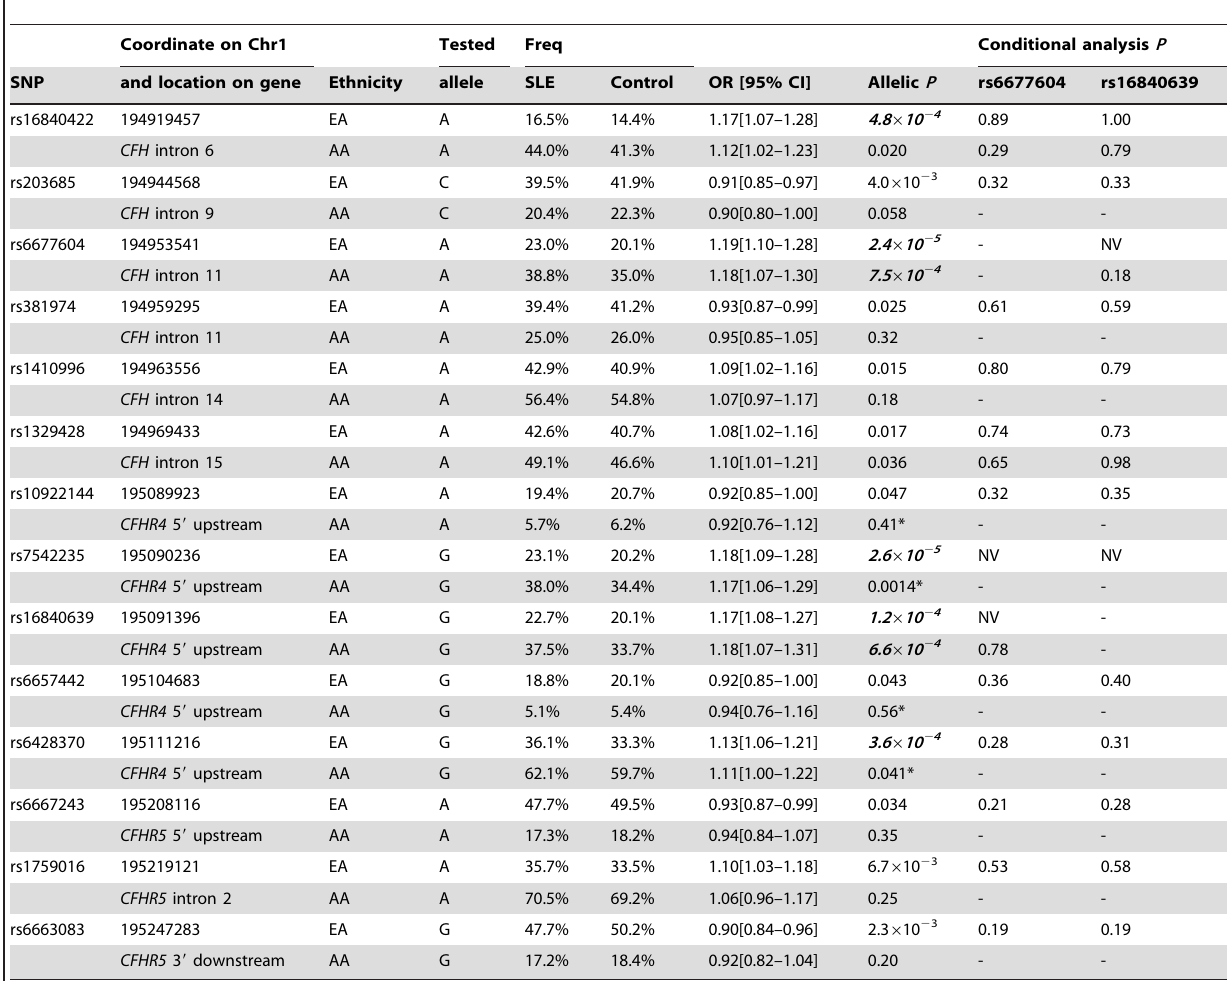
Table 1. Association of SNPs in the CFH-CFHRs region with SLE in European Americans and African Americans.